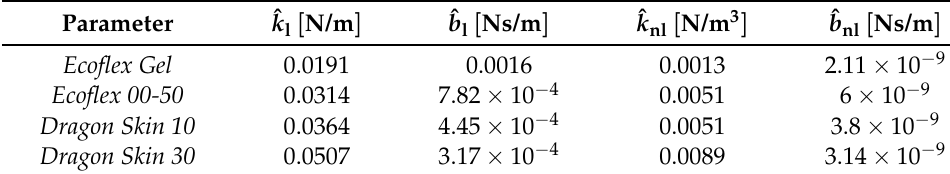
Table 2. Standard deviations σ of the estimated